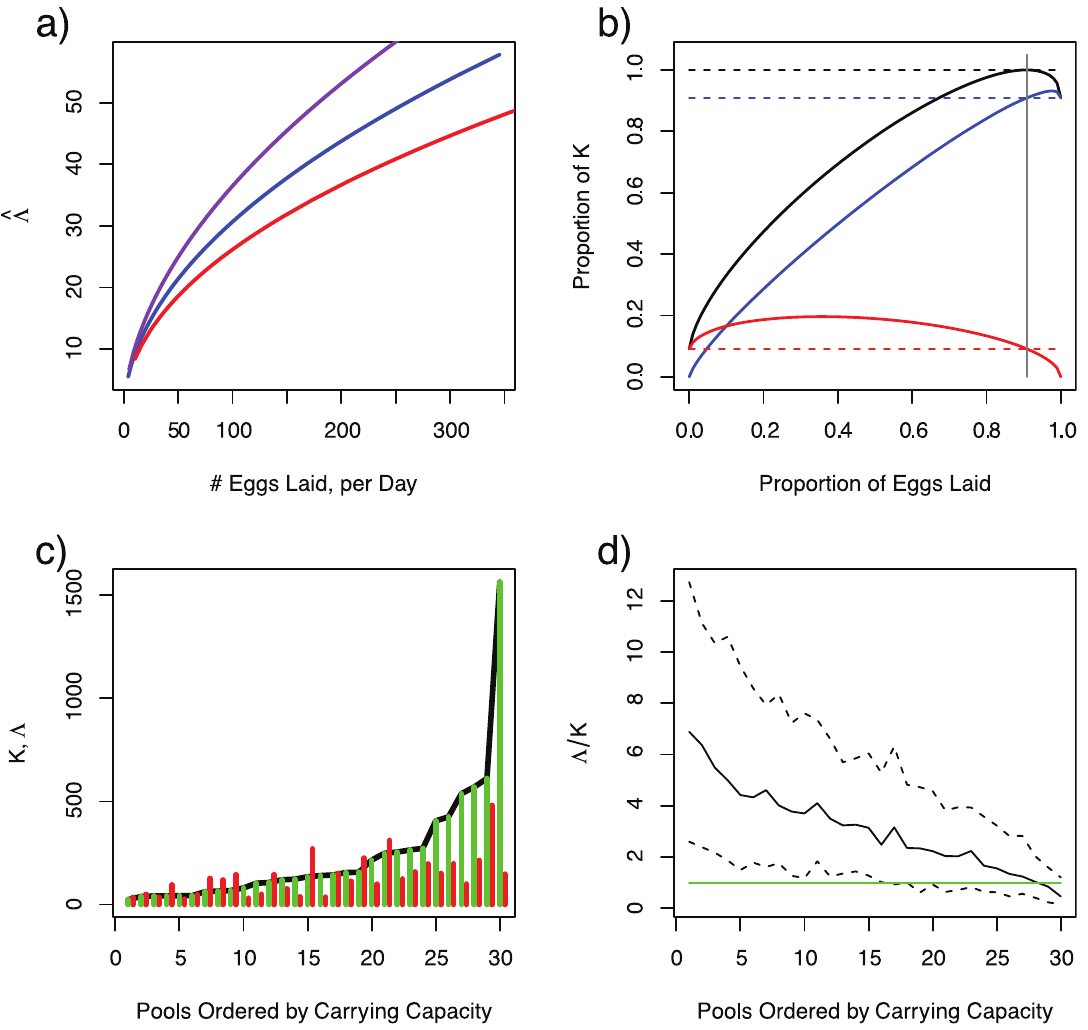
Figure 1. Understanding productivity ( i.e. , the emergence rate of adults (cid:2) LL ) in heterogeneous habitats depends upon understanding the relationship between egg laying, carrying capacity ( K ), and crowding. a ) The functional relationship between the rate of egg-laying and productivity depends on the functional response to crowding. In this model, the relationship is sensitive to the power-law scaling relationship ( s ~ 1, blue; s ~ 1 : 1, red; s ~ 0 : 9, purple). Carrying capacity is given for a single value of egg laying rates, given at the steady state if that pool had existed in isolation. b ) In a system with 2 pools linked by egg-laying, where the carrying capacity of pool 1 is approximately 90% of the total (dashed blue line) and pool 2 has the rest (dashed red line), the population totals overall (solid black) are generally below the maximum, unless egg laying is fine-tuned such that the proportion of eggs laid was equal to that pool’s proportion of carrying capacity (vertical grey). c ) A comparison of productivity (red) and carrying capacity (black line) for a typical set of heterogeneous aquatic habitats. Productivity equals carrying capacity when the K i ). d ) The ratio of productivity to carrying distribution of eggs laid is finely tuned to match the distribution of carrying capacities (i.e. p i ~ K i = P i capacity was computed for 100 sets of heterogeneous aquatic habitat. The green line plots the 1:1 ratio, when productivity equals carrying capacity. These distributions, plotted here as the median (solid line) and the 10 th and 90 th quantiles (dashed lines), shows the robust pattern that the habitats with the lowest productivity tend to be under capacity and the few highly productive habitats tend to be over